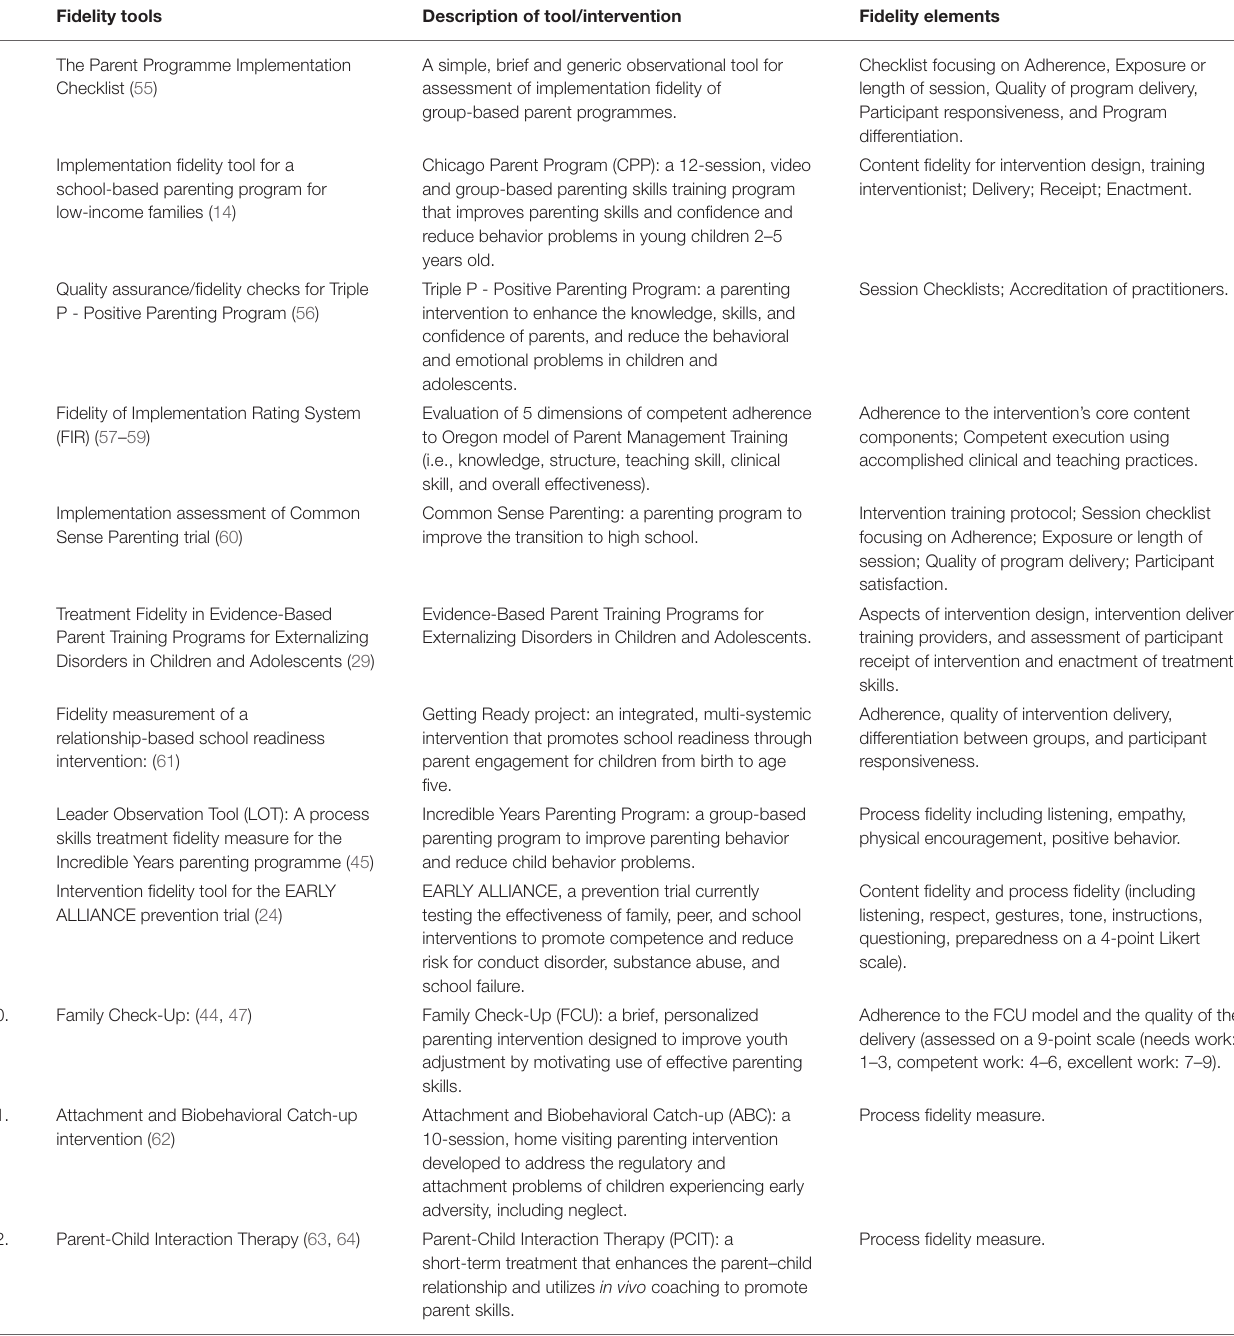
TABLE 1 | Review of extant fidelity tools for parenting